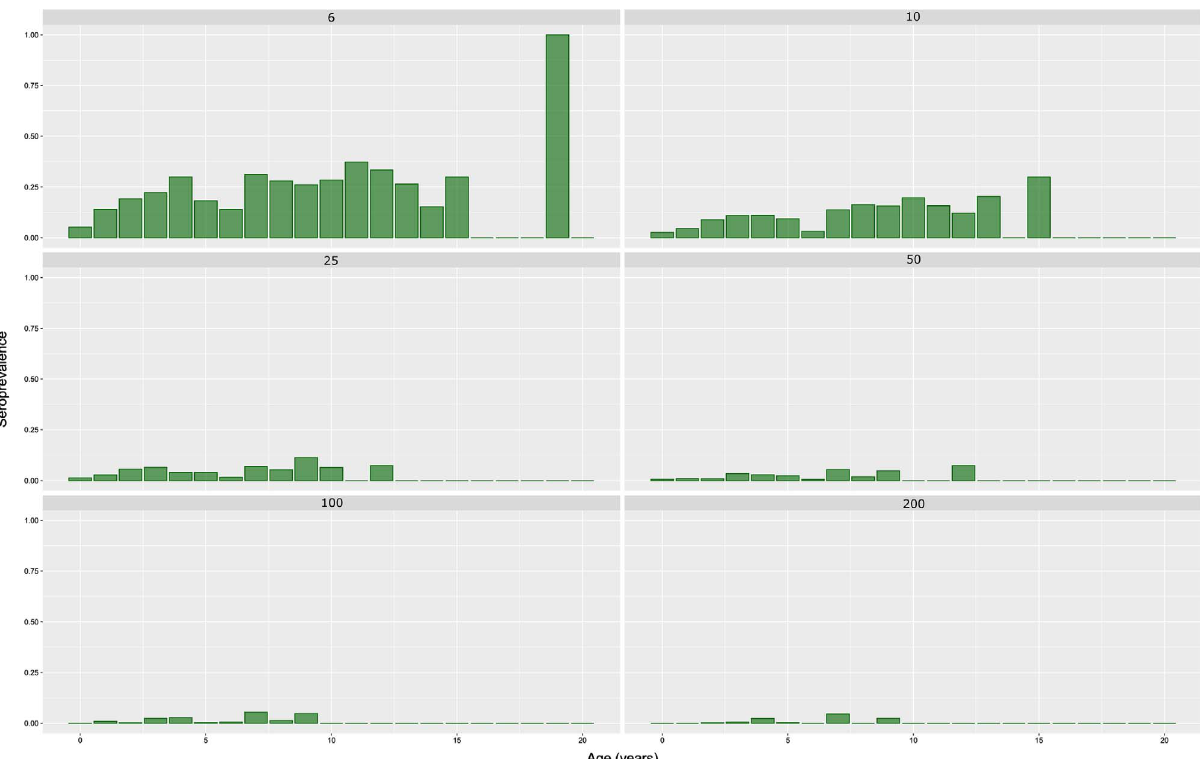
Figure 4. Seroprevalence of Toxoplasma gondii infection in bovines of French origin (adults + calves) accordingly to the age and the titer (6; 10; 25; 50; 100; 200).